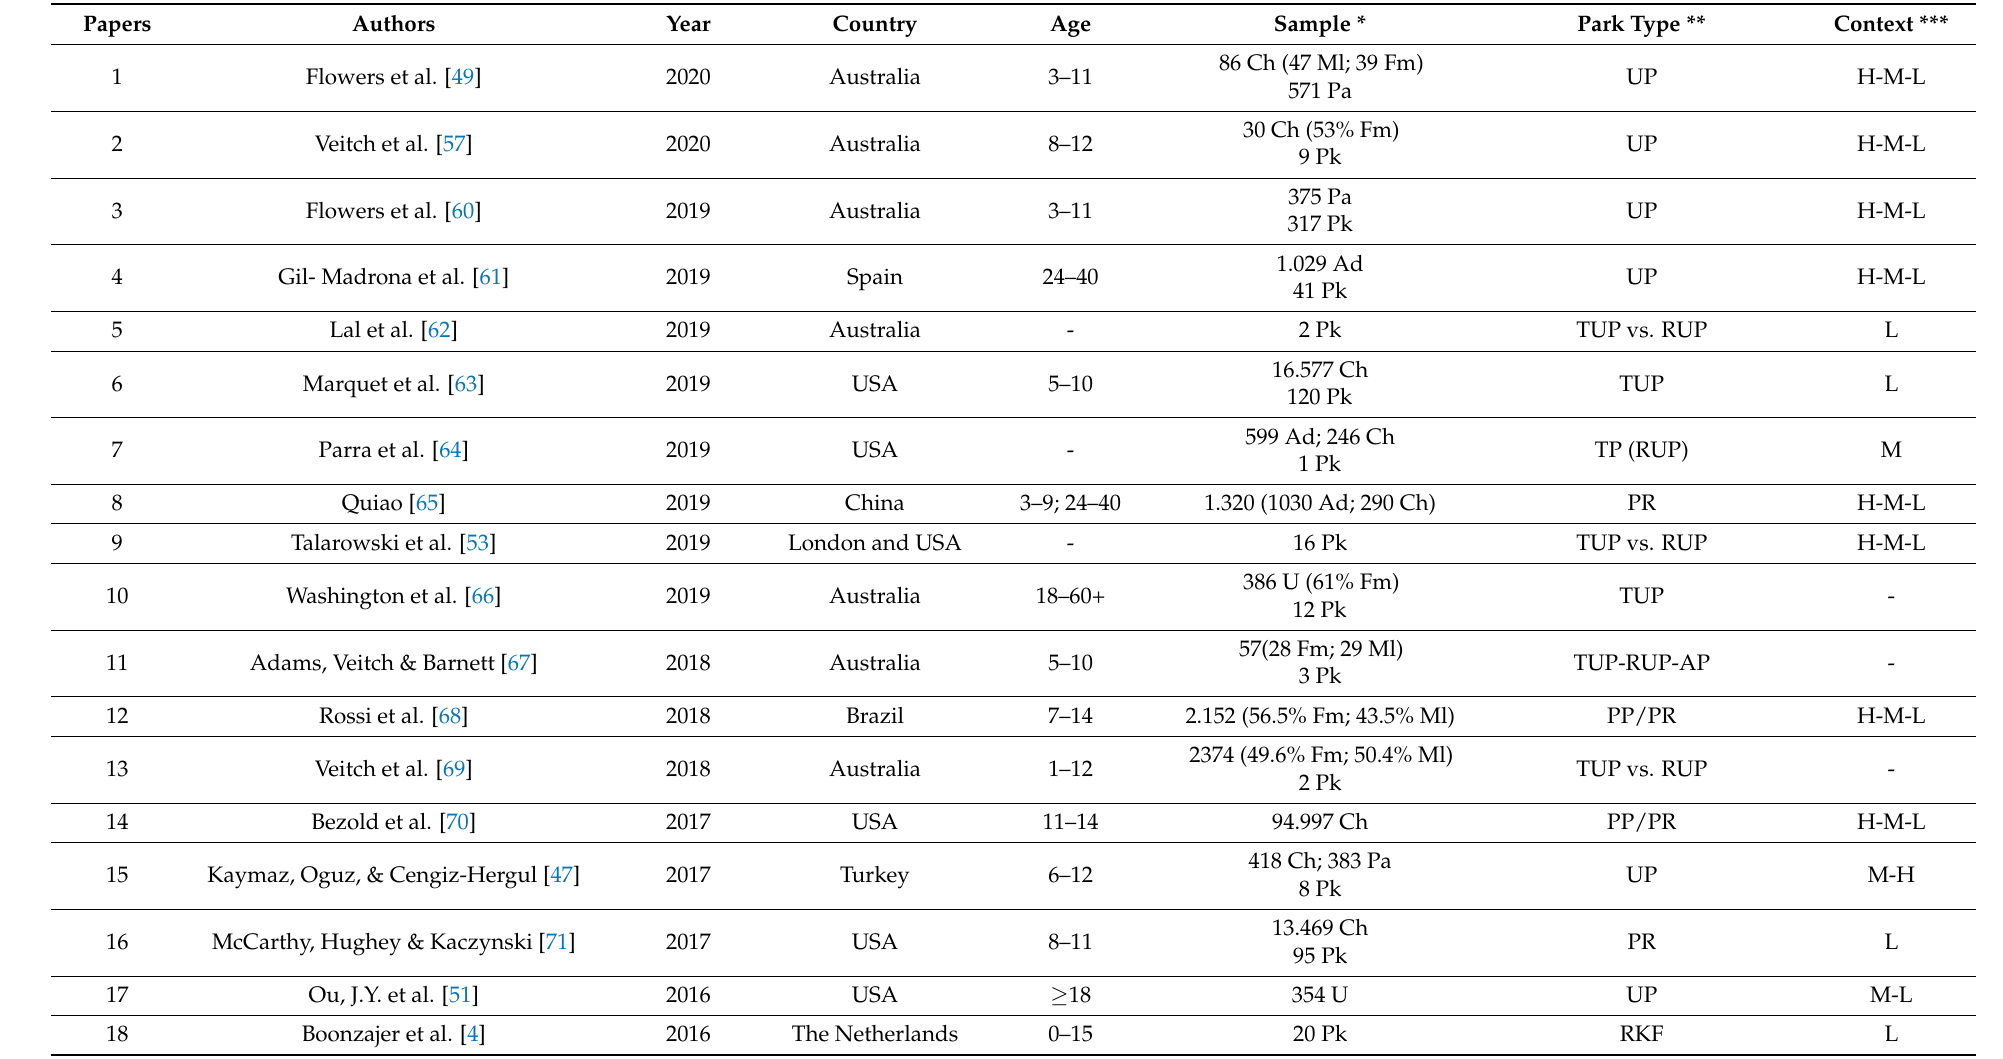
Table 1. Data related to the selected